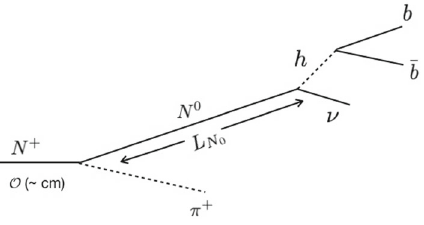
Fig. 3 Schematic diagram of N ± → N 0 π ± and N 0 → h ν